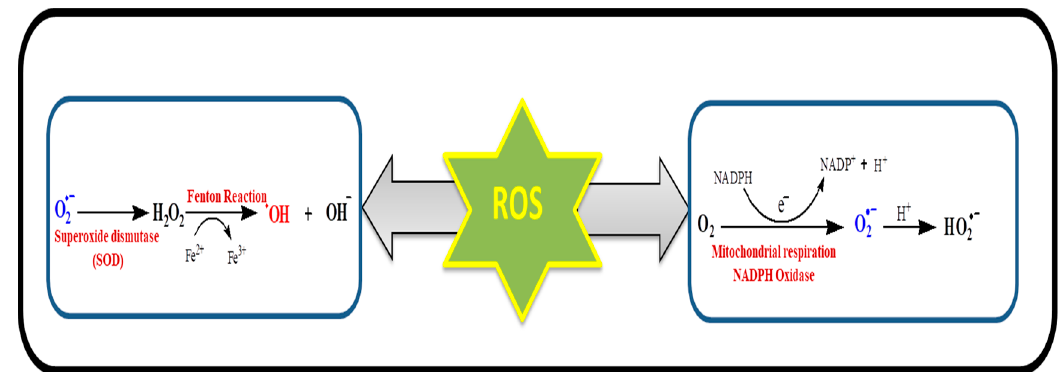
Figure 3. Various reactions for ROS generation. The superoxide (O 2• − ) is produced from molecular oxygen (O 2 ) in the mitochondria or NADPH oxidase as by-product of respiratory chain. Superoxide can be transformed into hydrogen peroxide via superoxide dismutase. Hydrogen peroxide further leads to the formation of hydroxyl radical and hydroxyl anions.